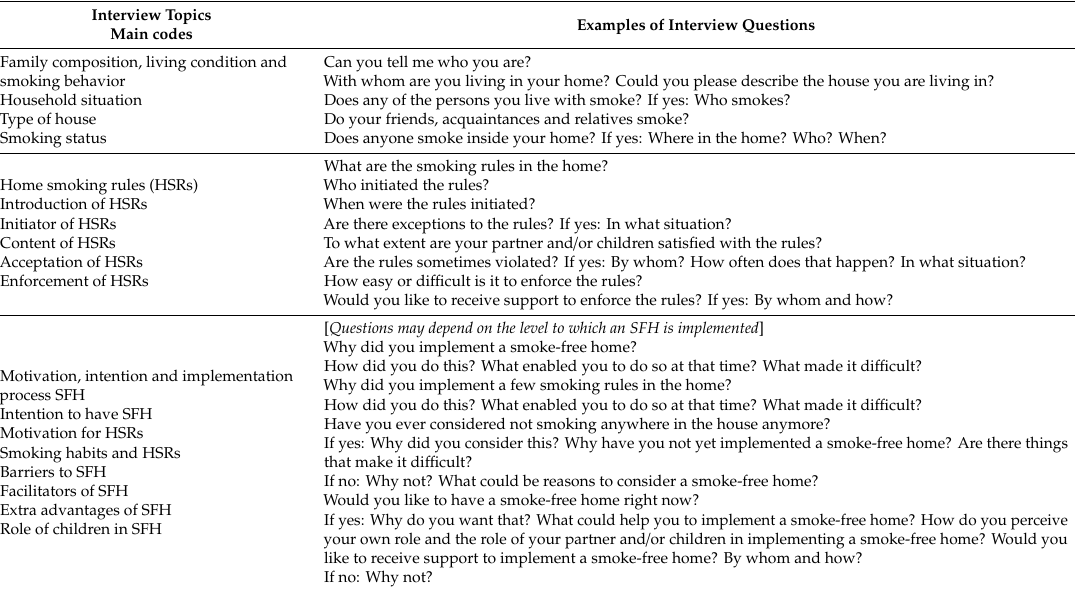
Table 1. Interview